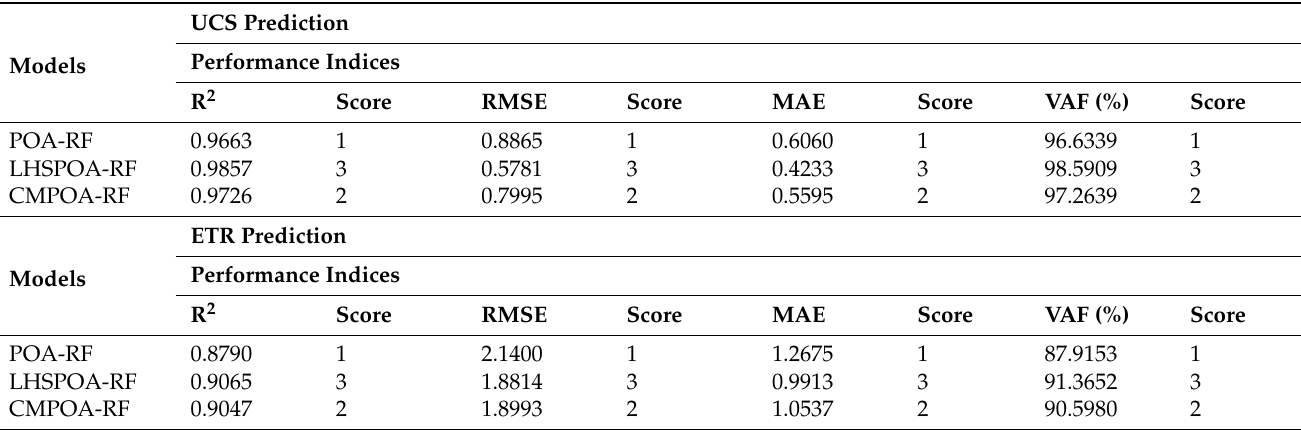
Table 7. The performance indices of the proposed models in the testing